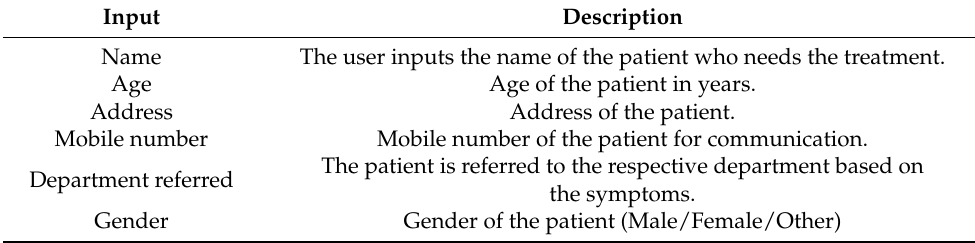
Table 1. Description of the patient registration